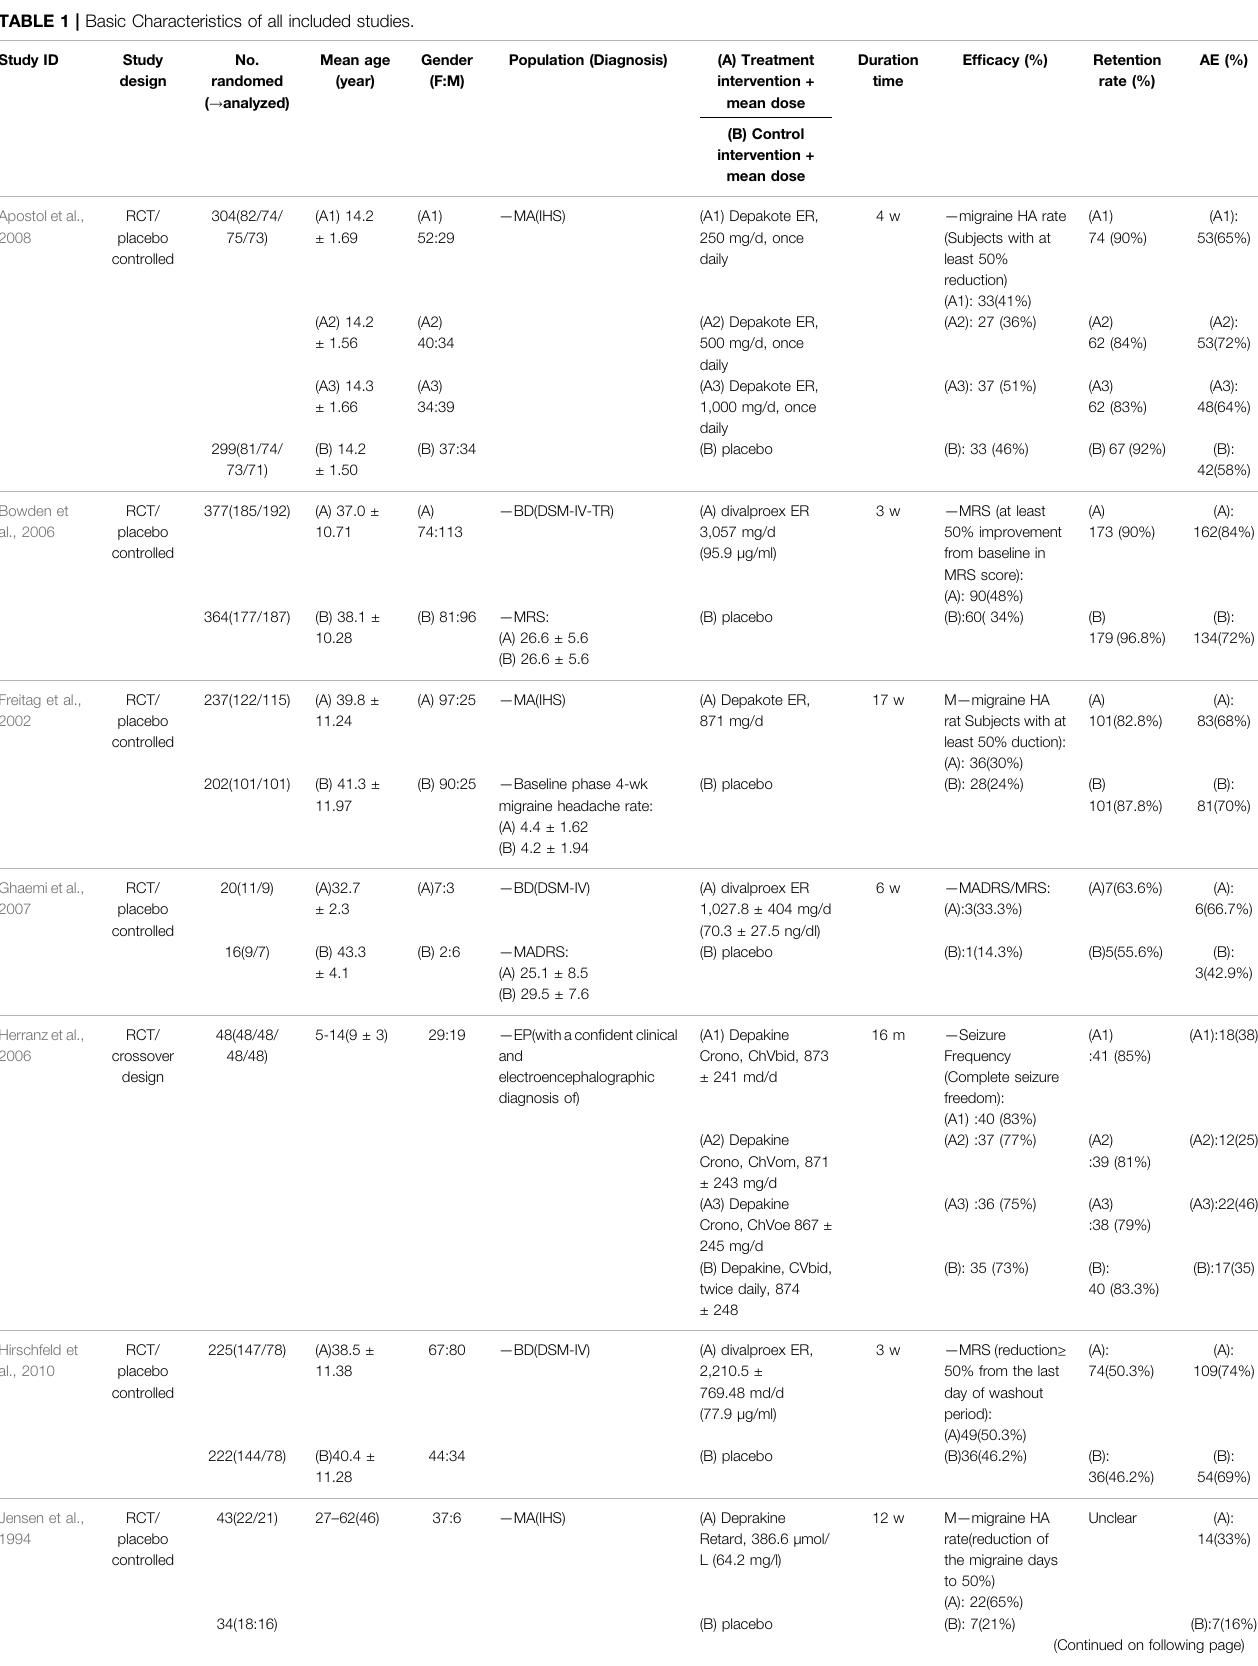
TABLE 1 | Basic Characteristics of all included